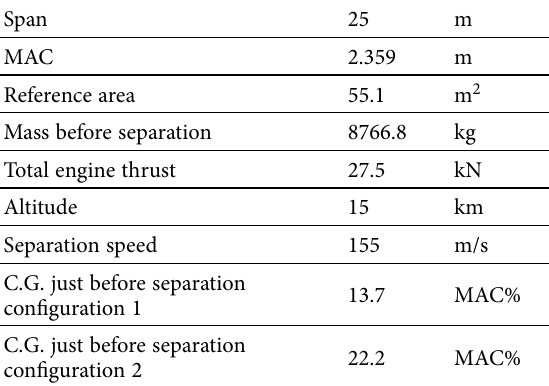
Table 1. Basic assumptions of the geometry and performance